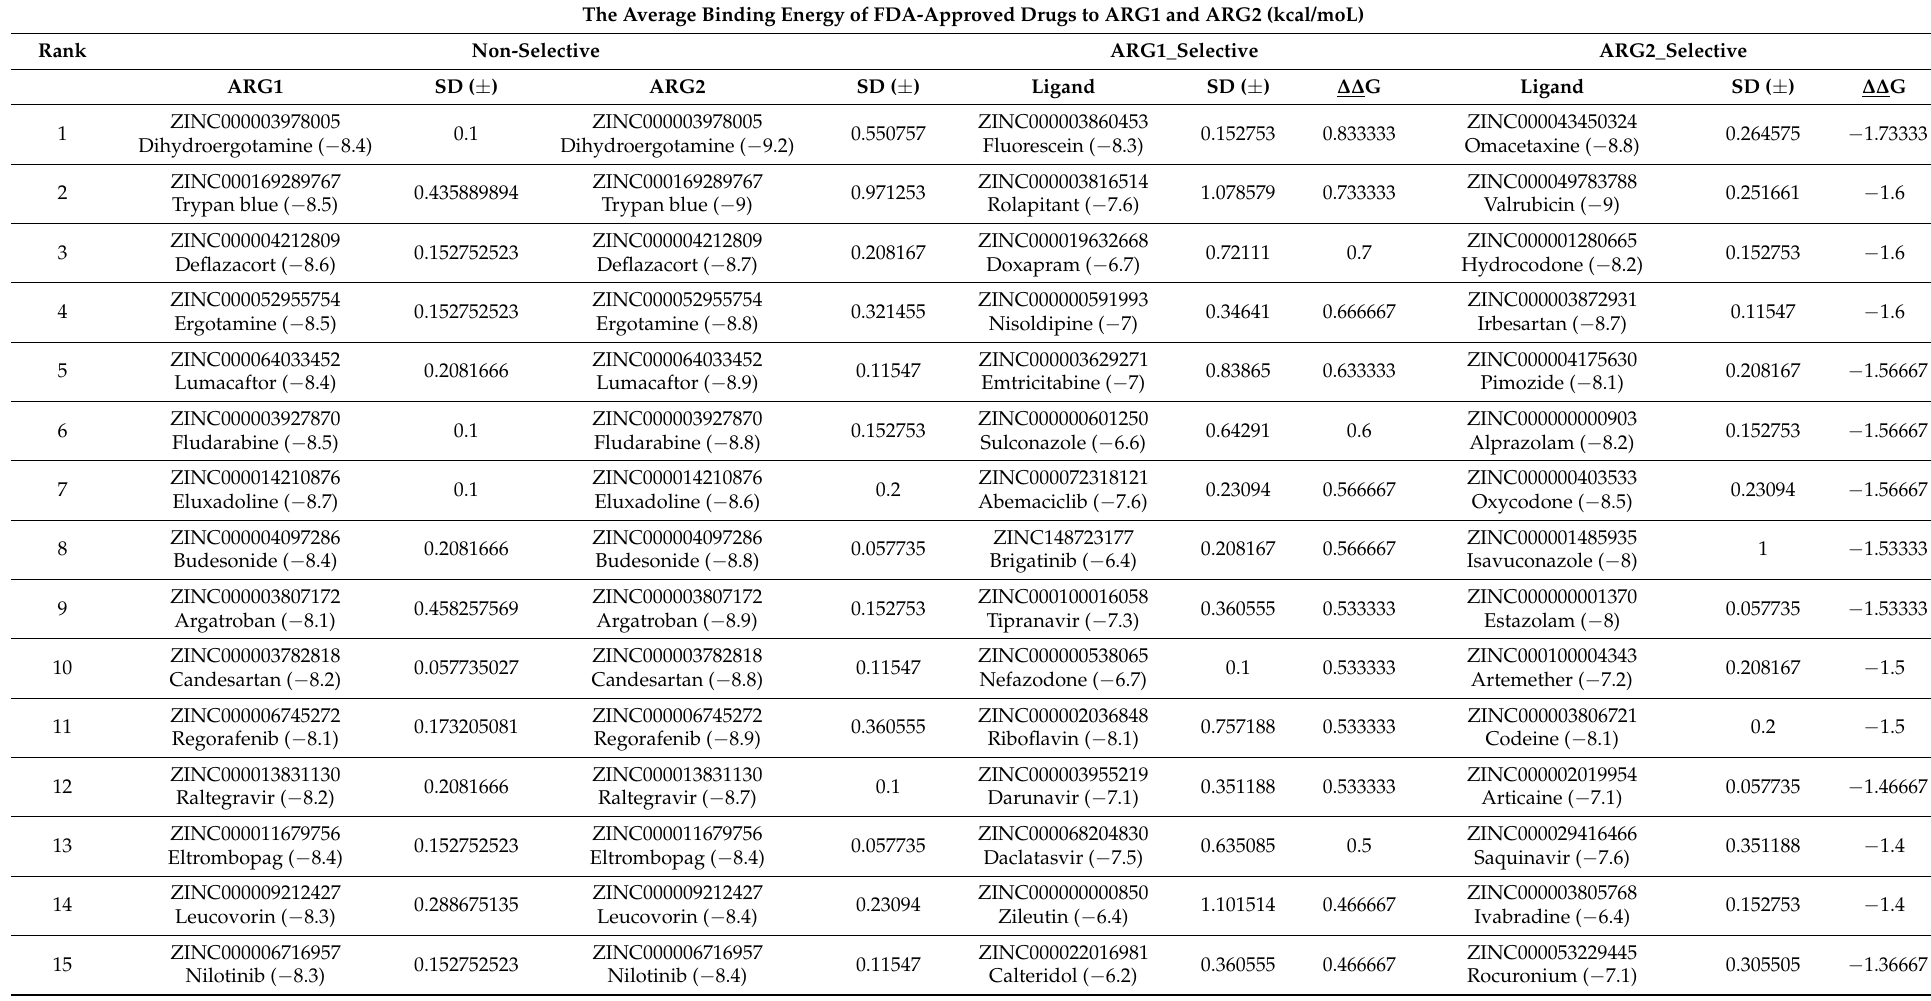
Table 1. Top FDA-approved drugs bound to ARG1 and ARG2